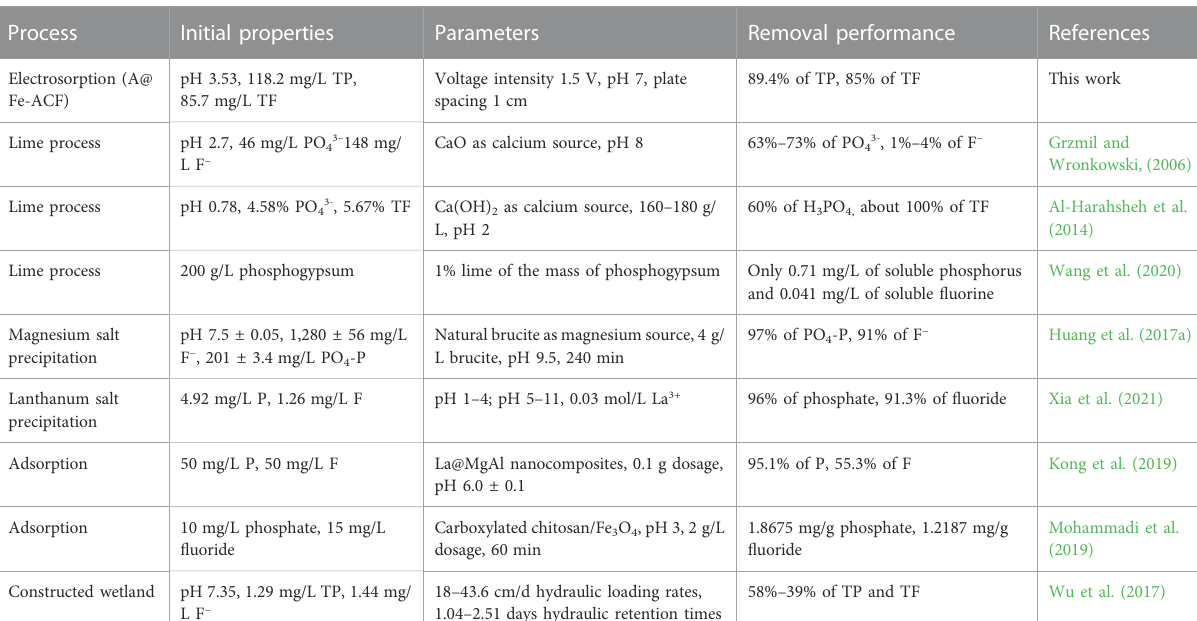
TABLE 1 Comparison between the different